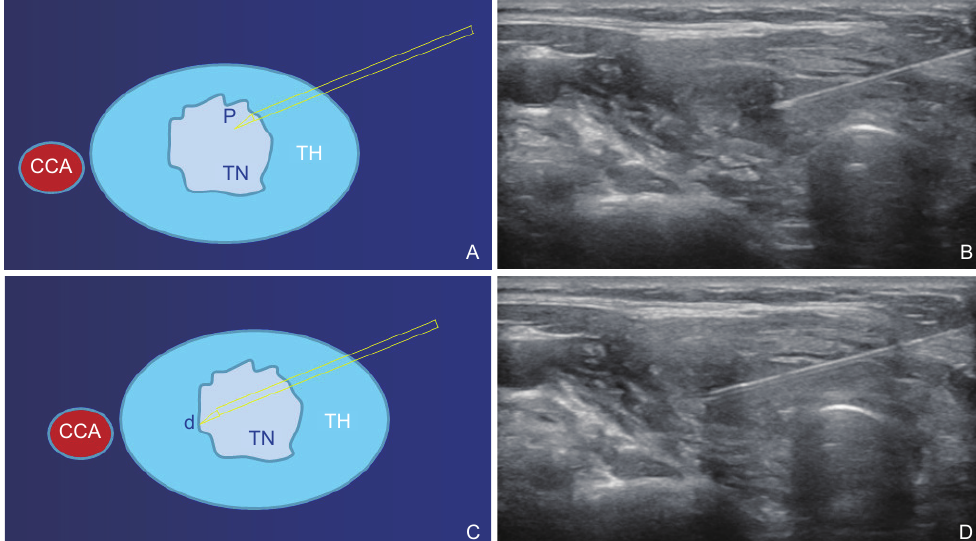
Figure 16 The large range puncture through the target nodules. (A) Diagram of the proximal puncture point of the target nodule (p-proximal point, TN- thyroid nodule, TH-thyroid, CCA-common carotid artery); (B) Diagram of the distal puncture point of the target nodule (d-distal point); (C) Ultrasonogram of the proximal puncture point; (D) Ultrasonogram of the distal puncture